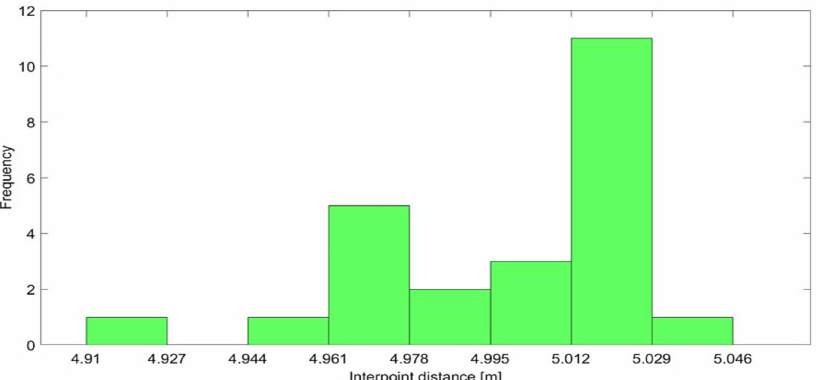
Figure 18. Histogram of the measured distances between two consecutive points considering the 24 possible combinations of the grid.